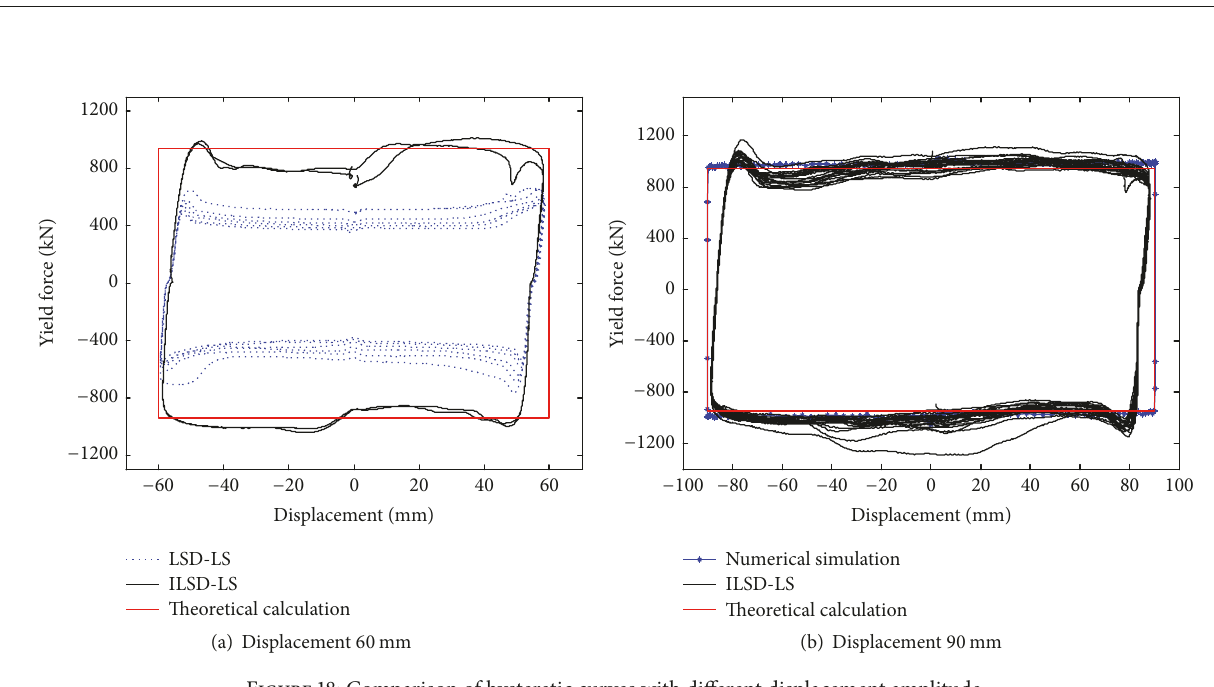
Figure 18: Comparison of hysteretic curves with different displacement amplitude.